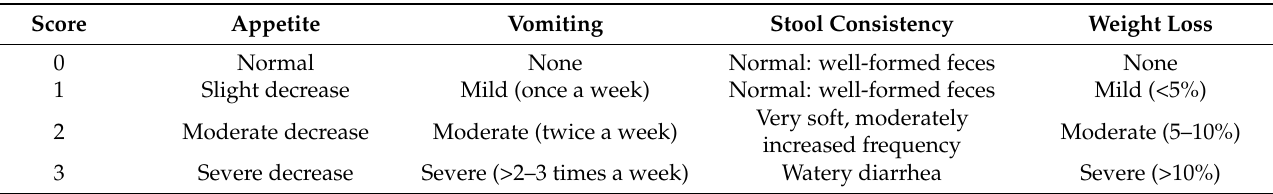
Table 1. Simplified FCEAI score used for clinical evaluation modified from